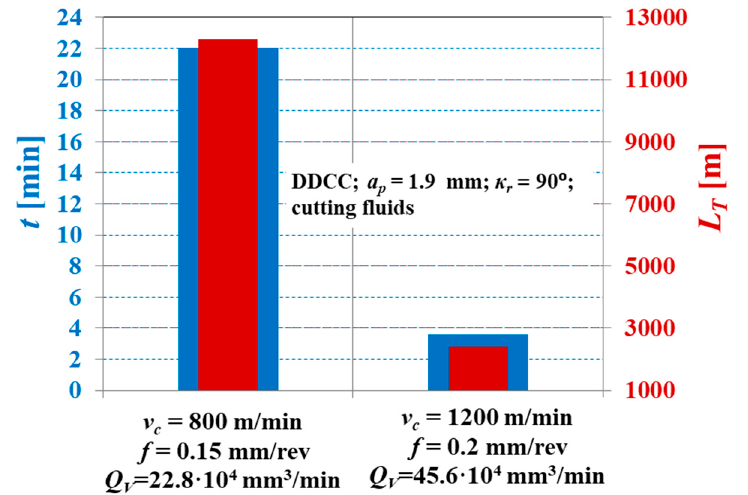
Figure 11. The comparison of tool life and cutting path over the tool life for DDCC inserts after grooving with various cutting parameters.